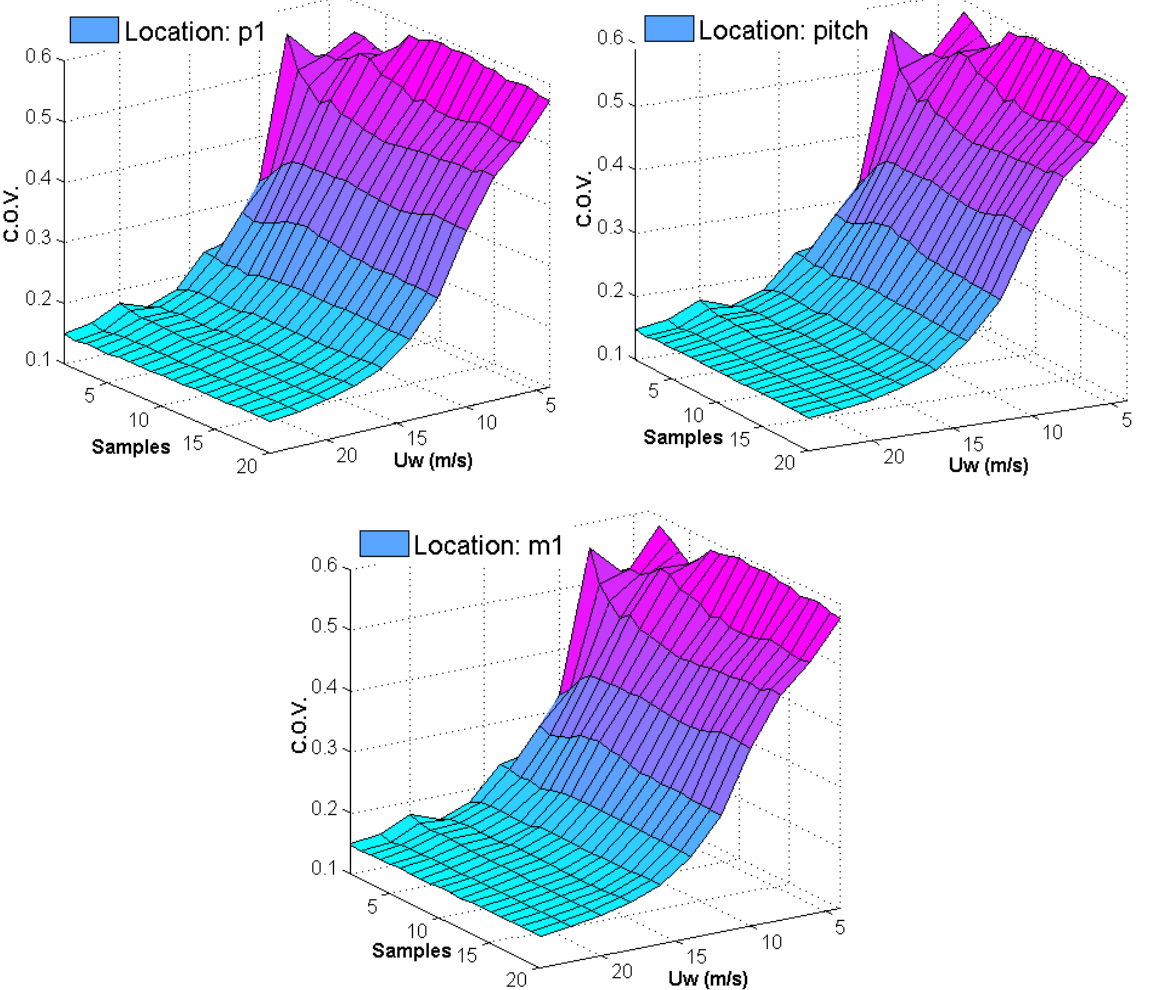
Figure 16. Variation of C.O.V. of the contact forces when using the 4P controller at different contact points, wind speeds and number of simulation